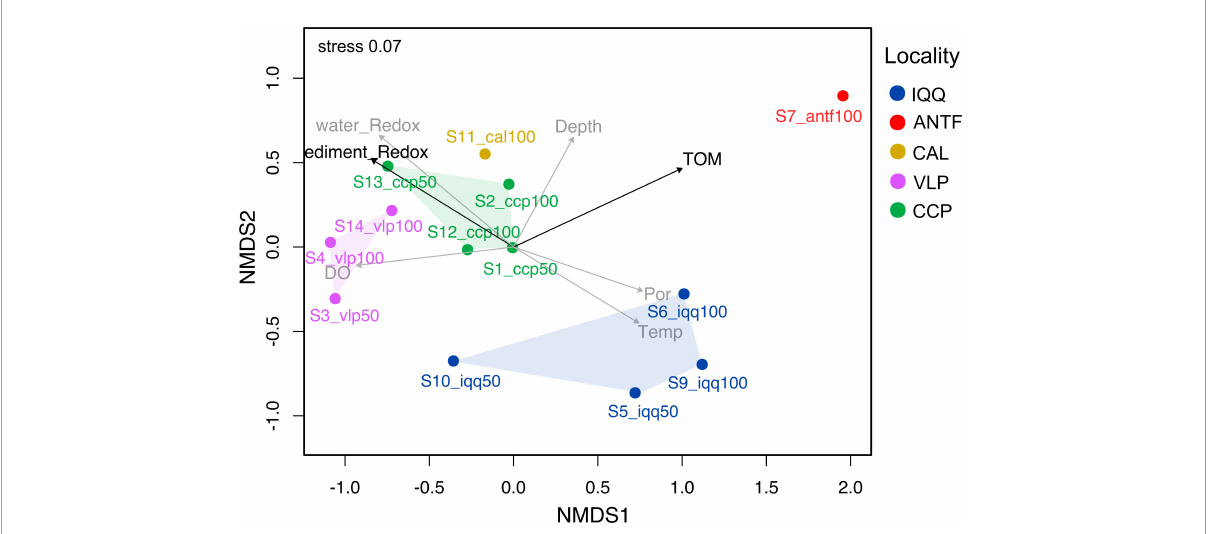
FIGURE3 Non-metric multidimensional scaling (NMDS) plot of the Bray-Curtis distance of the bacterial community with environmental parameters added using envfit. The NMDS was constructed over the Bray-Curtis dissimilarity matrix. The data was rarefied at 8,000 sequences per sample. The black arrows represent a statistically significant relationship ( p < 0.05) measured through the Mantel or envfit test. The added parameters were the redox potential of sediment and water, the percentage of total organic matter (TOM), depth, temperature (Temp), and porosity